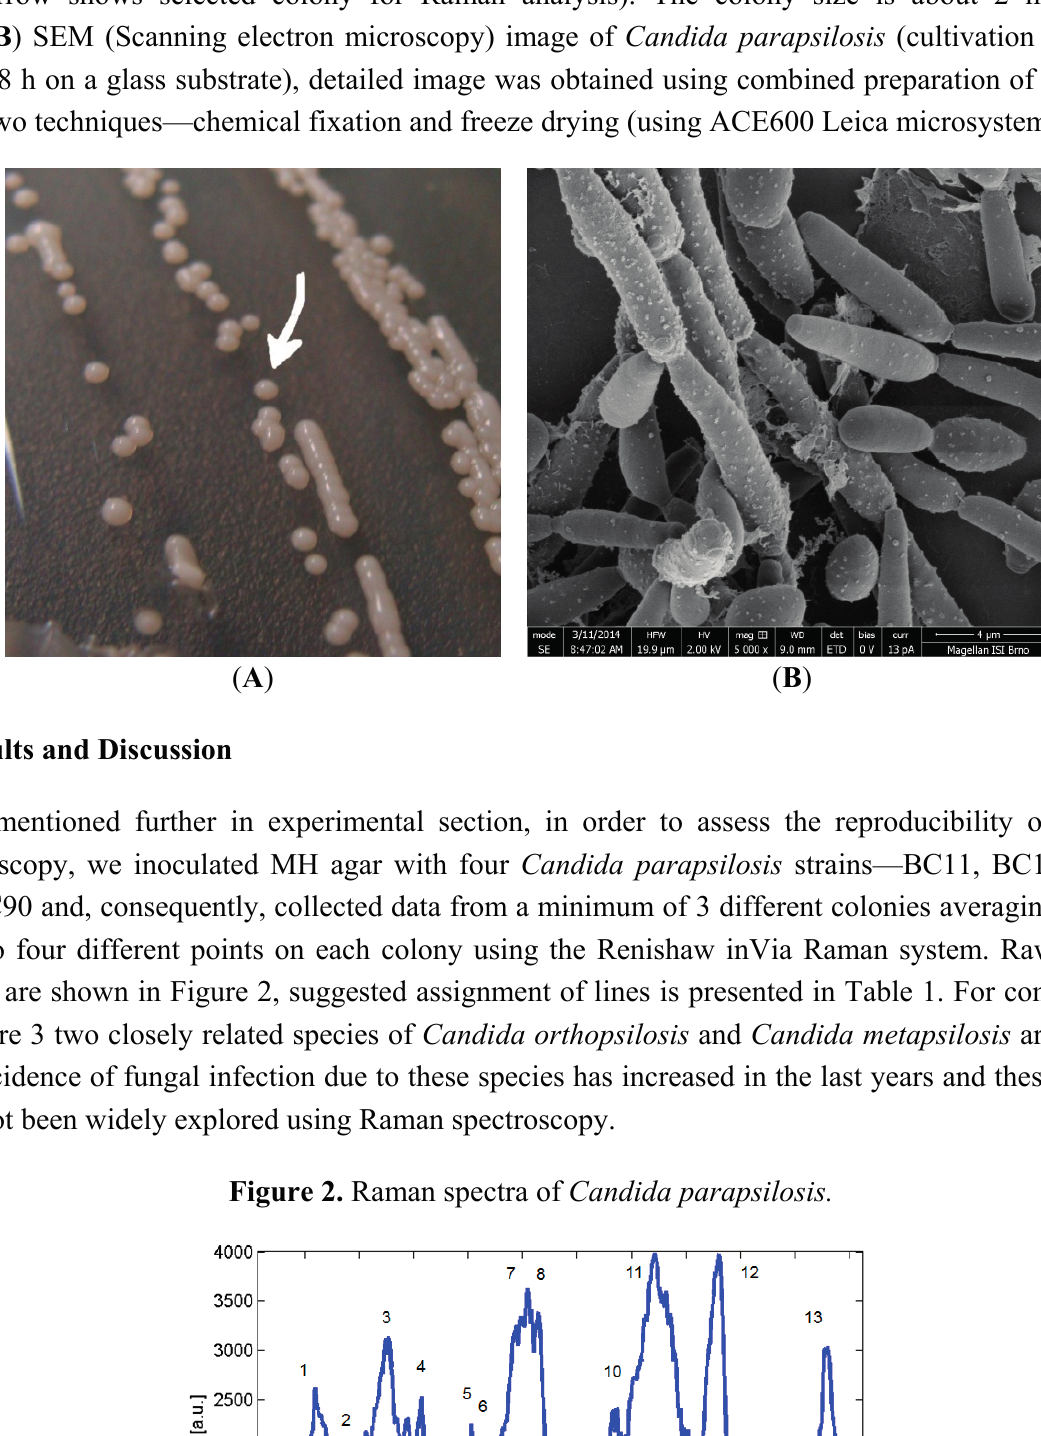
Figure 1. ( A ) Image of Candida parapsilosis colonies cultivated on agar for 48 h (the arrow shows selected colony for Raman analysis). The colony size is about 2 mm;